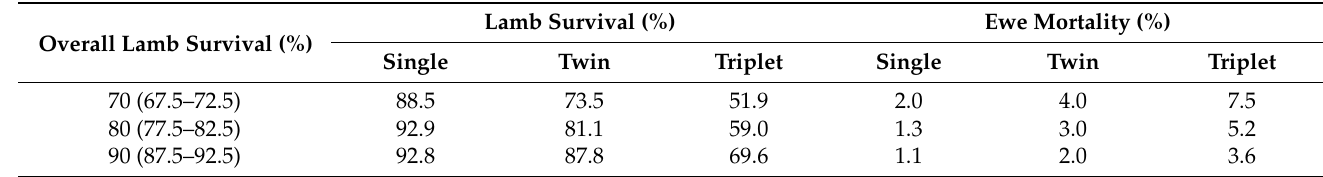
Table 5. Lamb survival and ewe mortality benchmarks corresponding to varying rates of lamb survival across whole flocks. The data were derived from 105 flocks from 64 survey participants that identified and differentially managed twin- and triplet-bearing ewes between pregnancy scanning and lamb marking in 2017 and 2018. Data include Merino and non-Merino ewe flocks. Lamb Survival